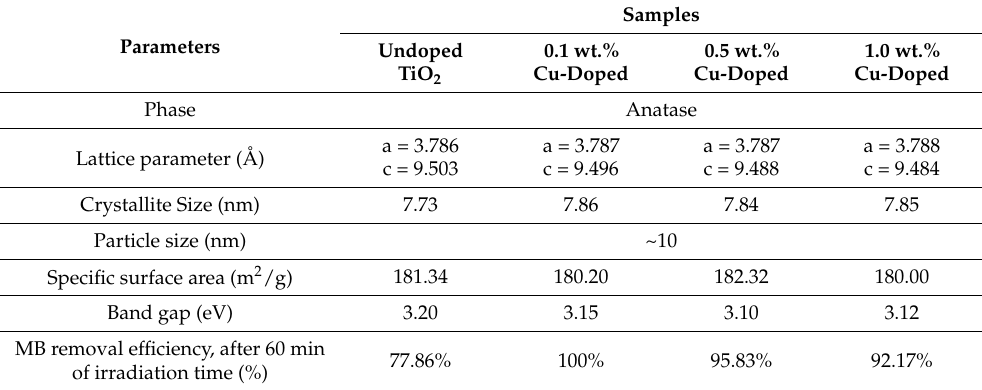
Table 1. Summary of analytical data.